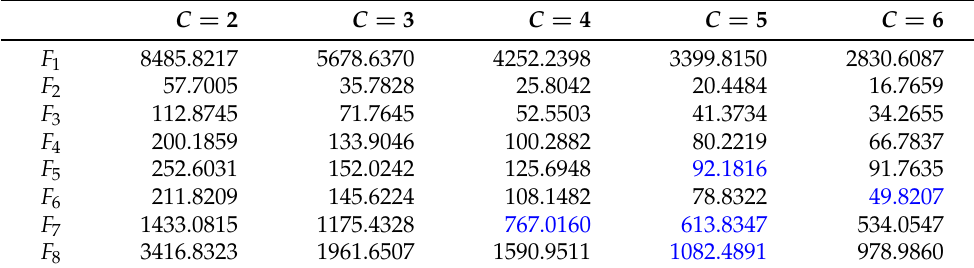
Table 6. Performance index J E using clusters obtained via fuzzy c-means (best values in blue).